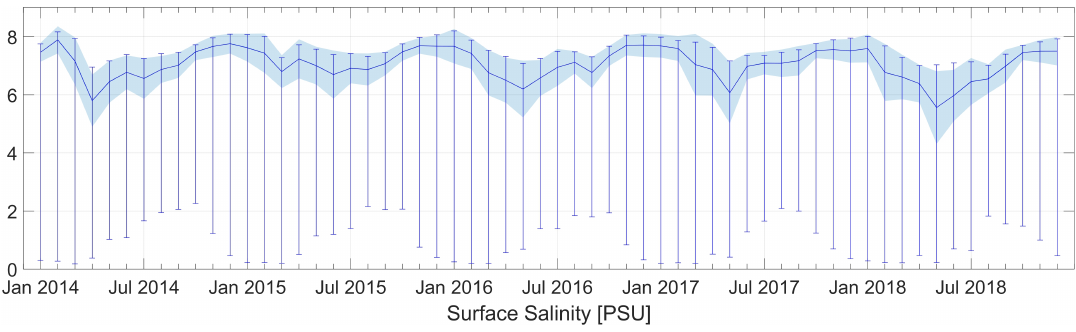
Figure 9. Monthly means of salinity at sea surface level for whole domain. Error bars represent minimum and maximum values. Solid line connects monthly means and shadow area shows standard deviation from the mean values.